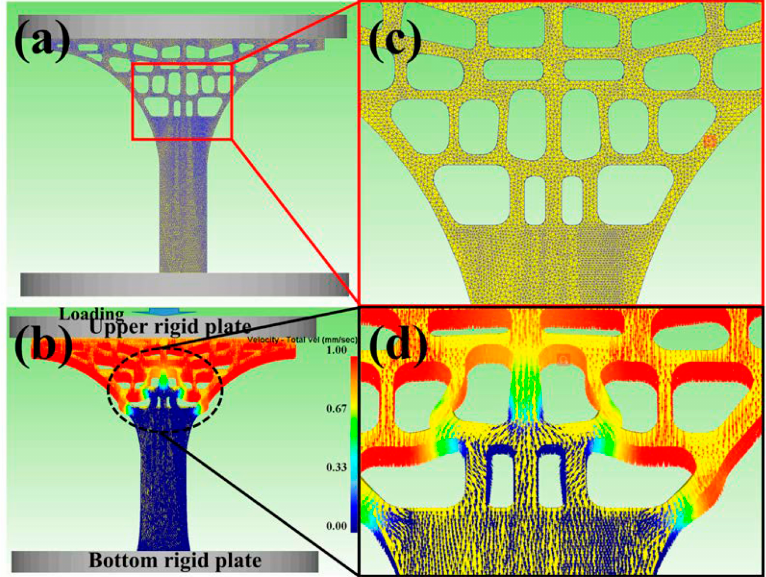
Figure 3. ( a ) The 3D-CAD model meshed with tetrahedral elements; ( c ) the enlarged view showing the FEM meshes; ( b ) The loading diagram by the speed loading; ( d ) the magnified view showing the velocity vector.